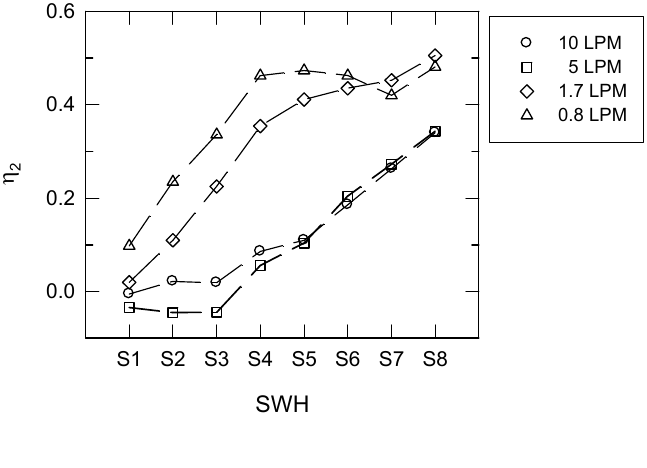
Figure 11. Accumulated energy of SWHs, continuous load